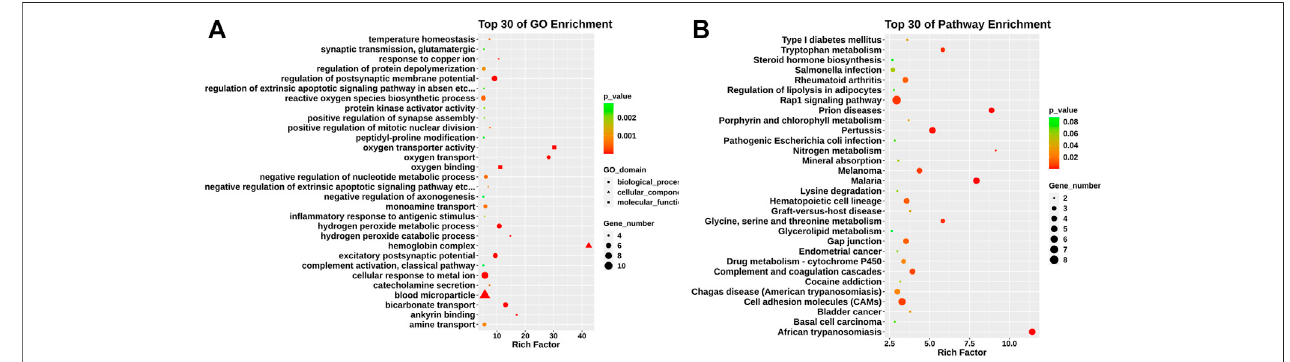
FIGURE 2 | GO and KEGG pathway analysis in relapsed GD CD4 + T cells. (A) GO analysis of differentially expressed genes between GD group and contols. According to biological process (circle), cellular component (triangle), and molecular function (square). (B) KEGG pathway analysis for differentially expressed mRNAs.